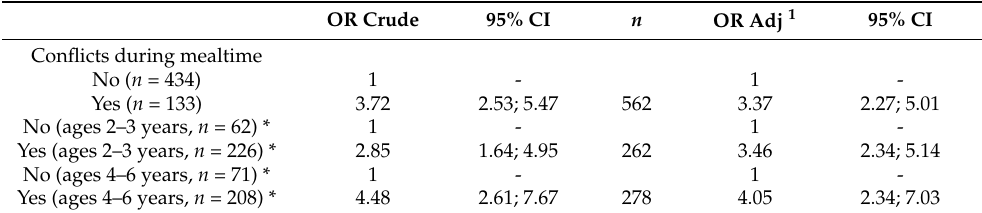
Table 3. Odds associated with changing from one picky category to the next in relation to conflicts during